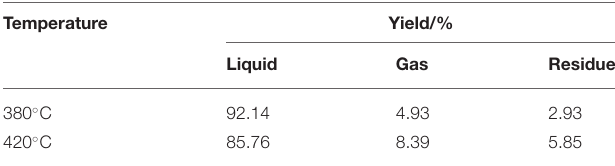
TABLE 2 | Contents of products obtained by tetralin and high-pressure hydrogen reaction. Temperature Yield/%